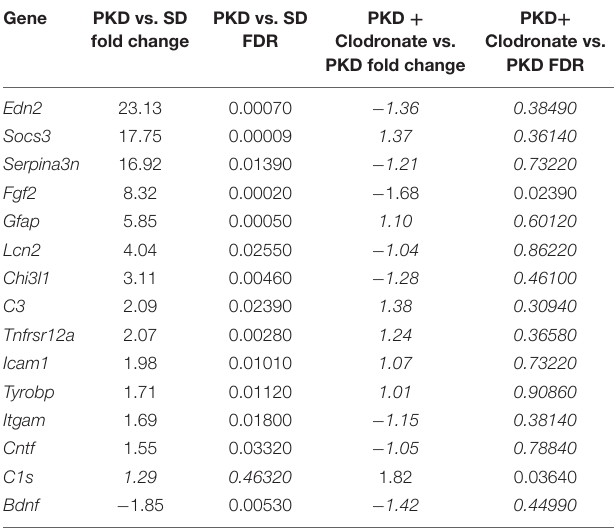
TABLE 1 | Differentially expressed genes associated with inflammation and vasoregression. Gene PKD vs. SD PKD vs. SD PKD + PKD + fold change FDR Clodronate vs. Clodronate PKD fold change